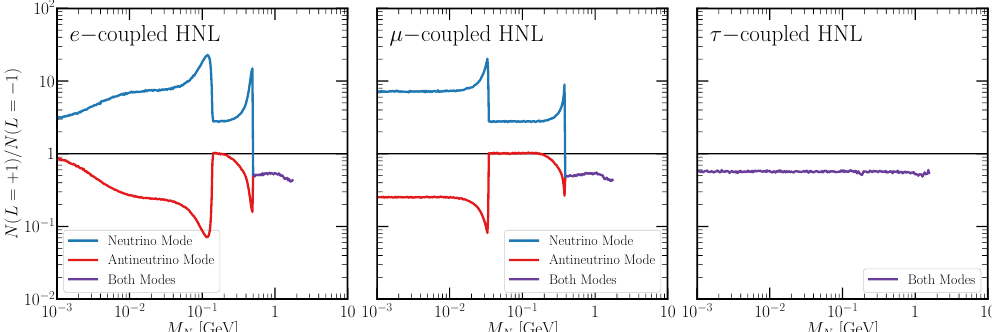
Figure 28 . Expected ratio of heavy neutral lepton decays with lepton number +1 to those with lepton number 1, assuming the HNL are Dirac fermions, as a function of the mass M N . The left (cid:0) panel is for e -coupled HNL, center is for (cid:22) -coupled HNL, and right is for (cid:28) -coupled HNL. For each panel, the blue (red) line corresponds to operation in (anti)neutrino mode. The results associated to the two operation modes overlap (purple lines) for M N & 400 MeV for the e - and (cid:22) -coupled scenarios and for all masses in the (cid:28) -coupled